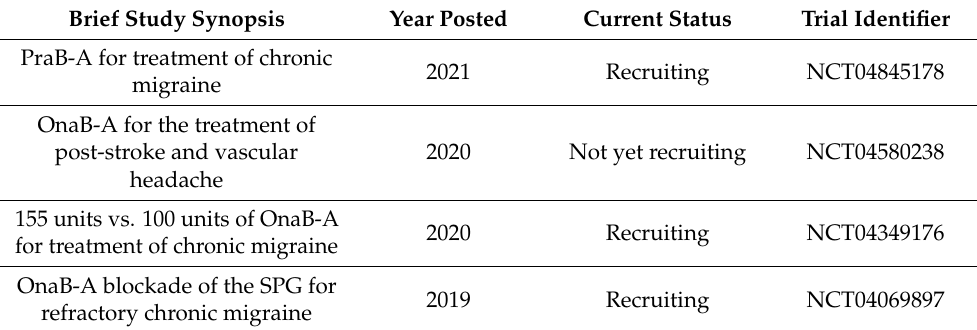
Table 2. Selected studies currently active involving botulinum